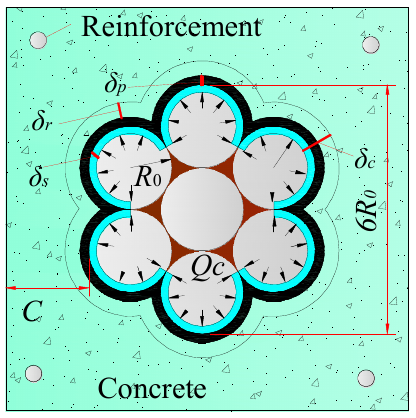
Figure 14. Expansive deformation at the strand-concrete interface.